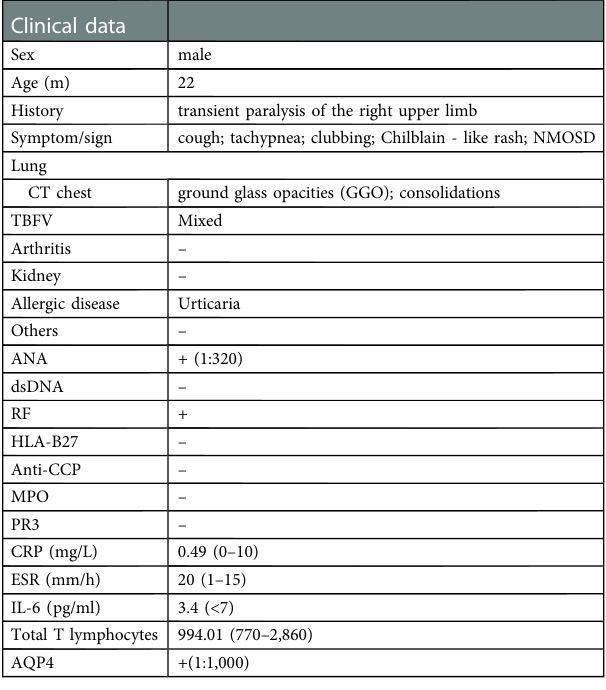
TABLE 1 Clinical data of the patient with COPA syndrome. Clinical data